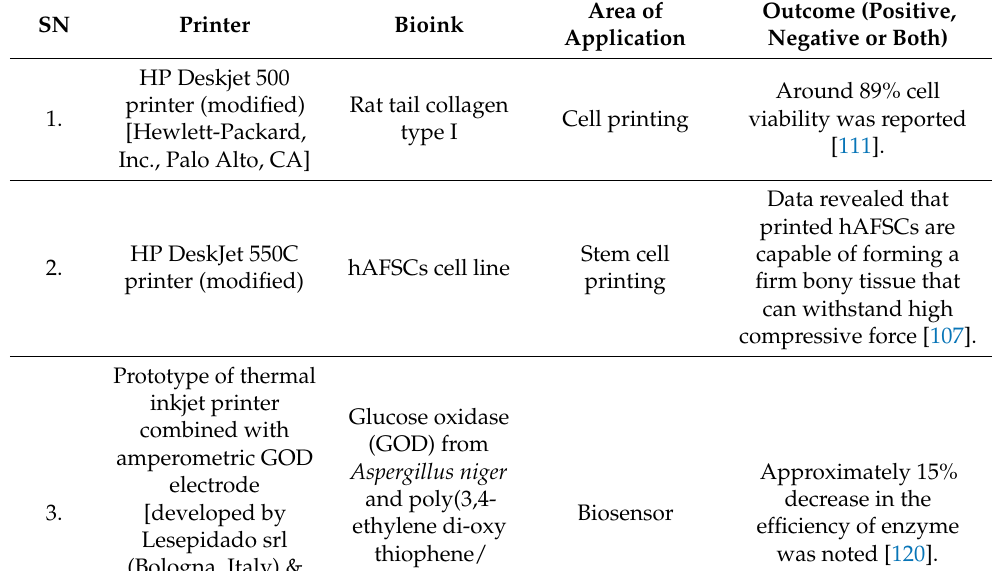
Table 3. List of thermal inkjet-based bioprinters with their applications & outcomes in biopharma- ceutical research